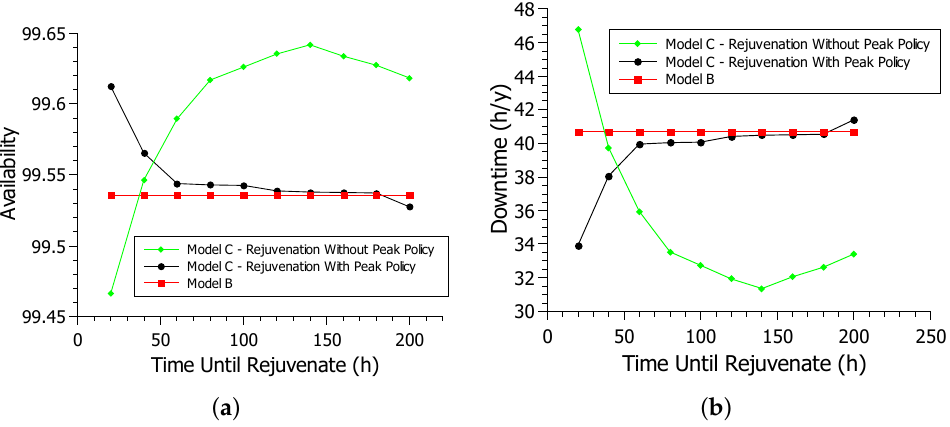
Figure 11. Comparison of levels of availability and downtime in relation to the rejuvenation model: ( a ) availability; ( b )